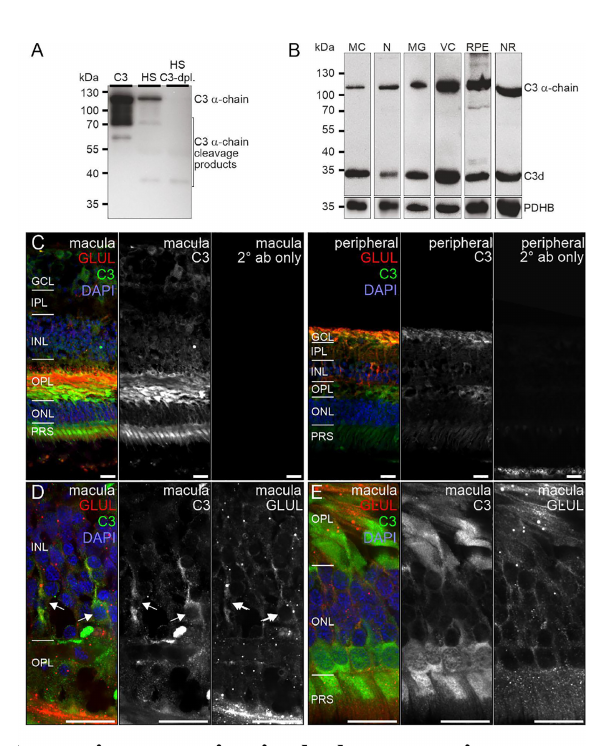
FIGURE 5 | C3 protein expression in the human retina. (A) The C3 a -chain (~120 kDa) and its cleavage products were robustly detected by Western blot if puri fi ed C3 or human serum (HS) was loaded. No characteristic bands were detected in C3-depleted HS. (B) Western blot analysis of C3 on puri fi ed retinal cell types from peripheral human retina and RPE/choroid. The total protein extracted per cell population was loaded. PDHB served as housekeeper since not the exact same amount of protein could be loaded given the low protein yield from the microglial (MG) and vascular cell (VC) populations. The C3 a -chain and its cleavage product C3d were detected in every retinal cell population at comparable levels. MC, Müller cells; N, retinal neurons; NR, whole neuroretina; RPE, RPE/choroid mixed samples. (C) Representative micrographs of C3- stainings from macular ( left ) and peripheral ( right ) retinae. Photoreceptors, photoreceptor terminals and Müller cell processes were positively labeled. Co- staining for the Müller cell marker glutamine synthetase (GLUL) demonstrated an overlap primarily in cells from the peripheral retina. (D) Higher magni fi cation of the inner nuclear layer (INL) highlighting the co-localization of C3 and GLUL (arrows). (E) Co-staining of C3 and GLUL did not result in an overlap in the outer retina. C3 stained cone photoreceptors (asterisk) which form a single row excluding rod photoreceptors from that layer in the central retina. (C – E) GCL, ganglion cell layer; IPL, inner plexiform layer; OPL, outer plexiform layer; ONL, outer nuclear layer; PRS, photoreceptor inner and outer segments. Scale bars, 20